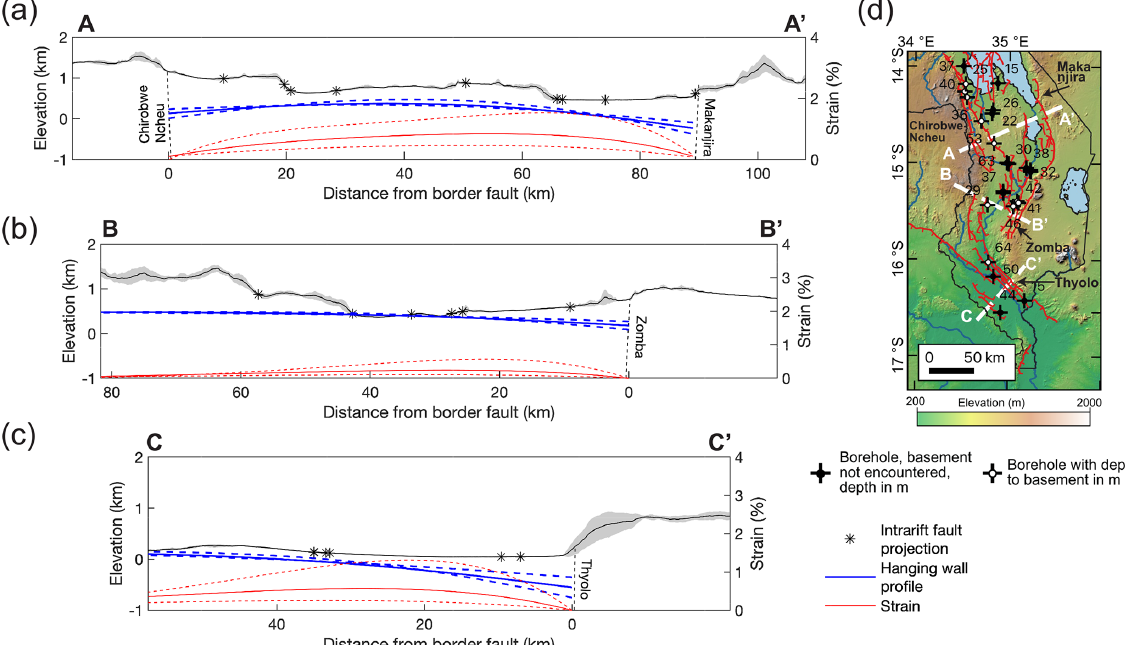
Figure A4. Modelled hanging wall flexural profiles and horizontal extensional strain in southern Malawi. Profiles have 6 × vertical exag- geration. Calculated following broken plate model (Fig. A3; Billings and Kattenhorn, 2005; Muirhead et al., 2016; Turcotte and Schubert, 1982) and parameters listed in Table A2. Solid hanging wall profile and strain line indicates median estimates, and the dashed line indicates maximum and minimum estimates. Solid black line and grey shading represent mean and 1 standard deviation topography from TanDEM-X 12m DEM in 10km swath centred on lines shown in panel (d) (Schwanghart and Scherler, 2014). Labelled faults indicate border faults. In panel (d) , the location and depth to basement in boreholes in south Malawi are also shown (Bloomfield and Garson, 1965; Habgood, 1963; Habgood et al., 1973; Walshaw, 1965; Walter, 1972). Map is underlain by the 30m resolution Shuttle Radar Topographic Mission digital elevation